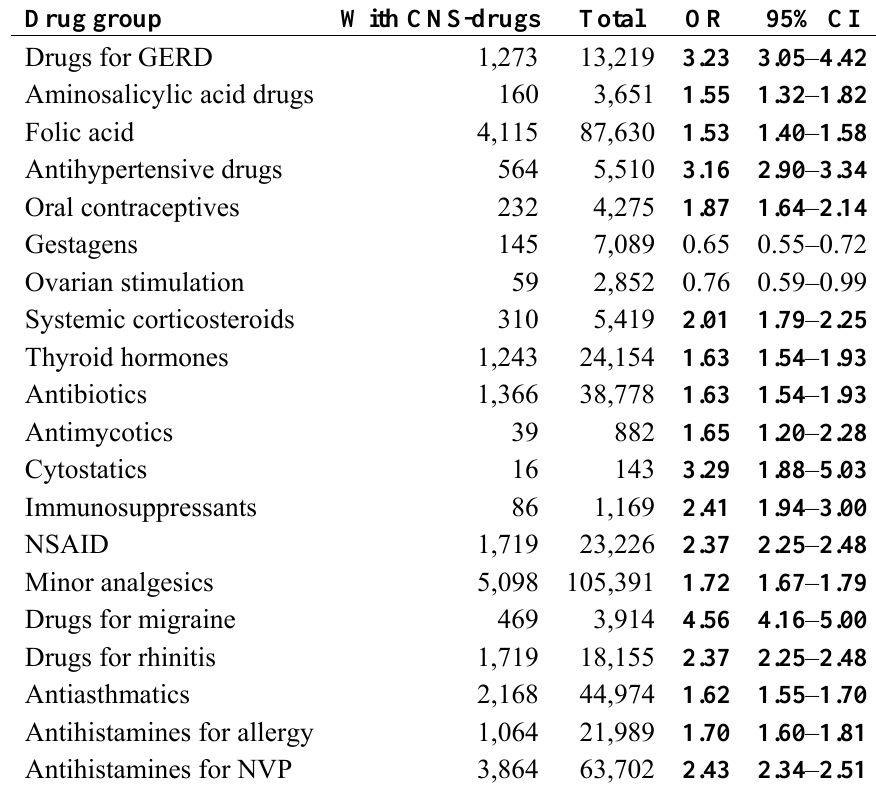
Table 3. Concomitant use of other drugs by women using CNS active drugs. ORs adjusted for year of birth, maternal age, parity, smoking, and BMI. Bold text